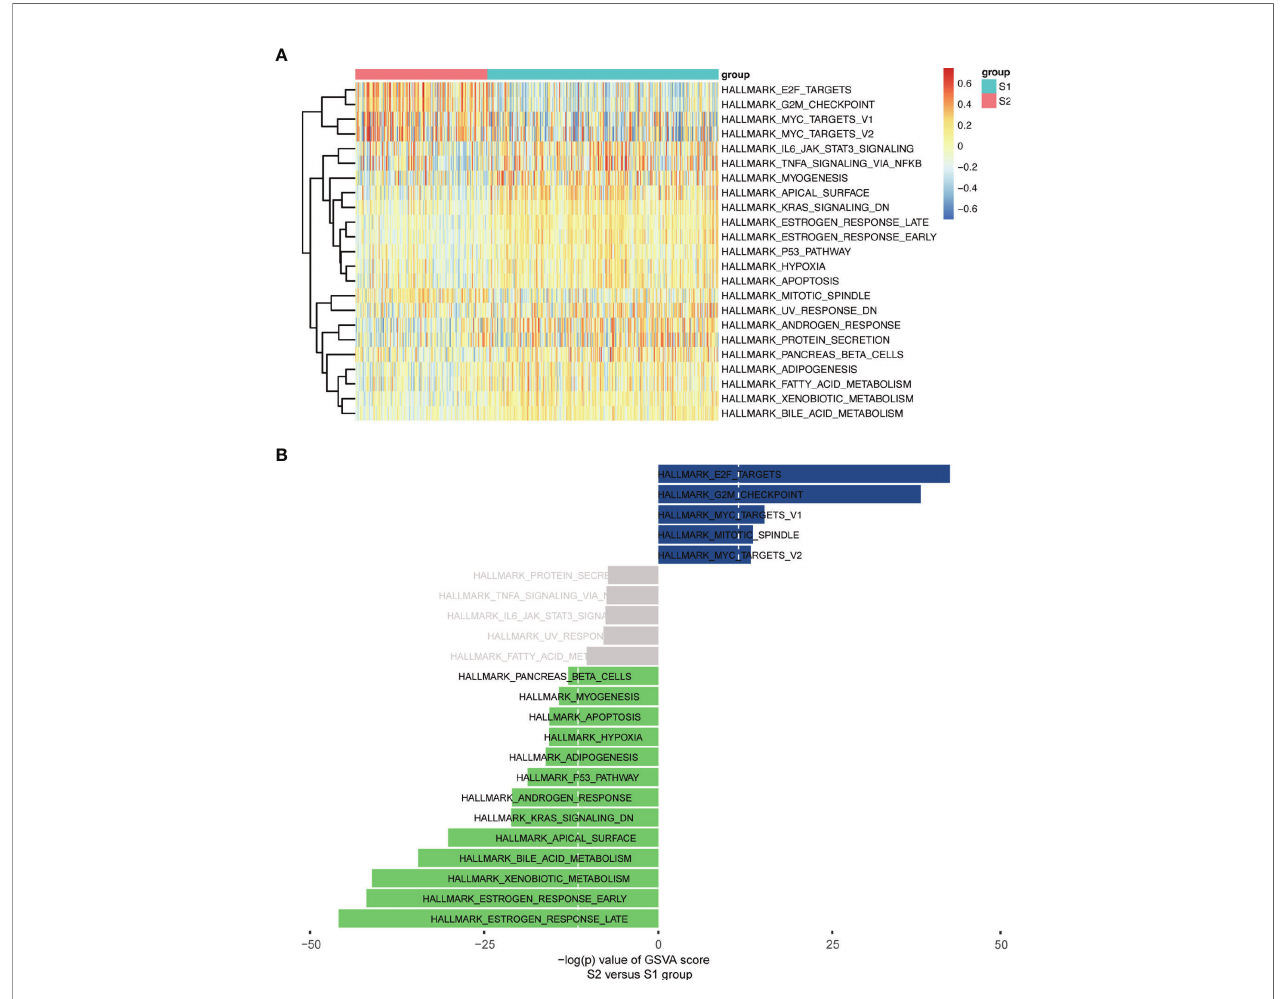
FIGURE 6 | GSVA enrichment analysis in Hallmarks. (A) Heatmap plot. (B) Bar Chart (-log(p) value of GSVA score were used, S2 vs